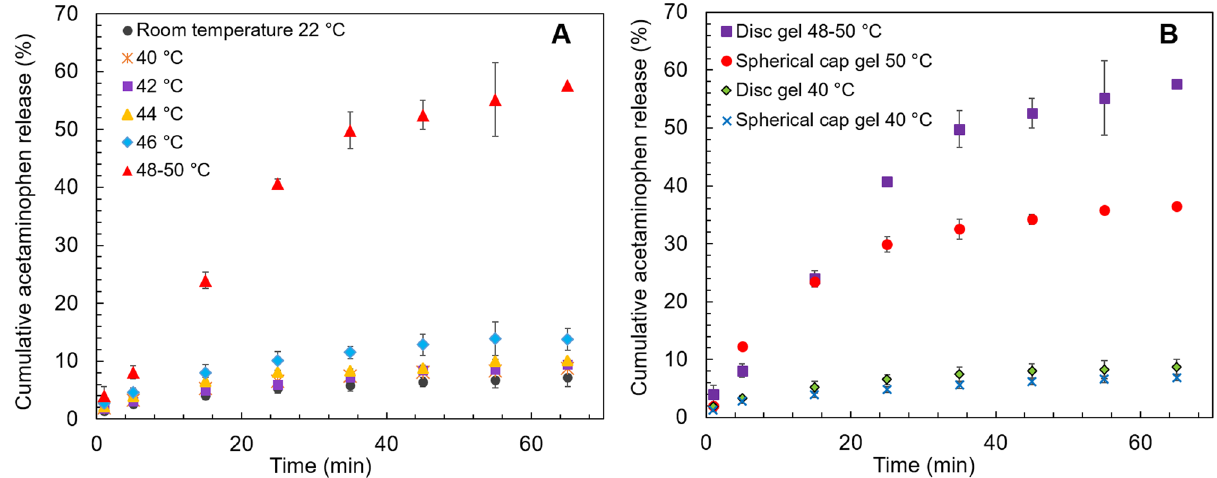
Figure 5. Cumulative acetaminophen release % with time from disc shaped ( A ) and disc vs spherical cap shaped ( B ) gels.